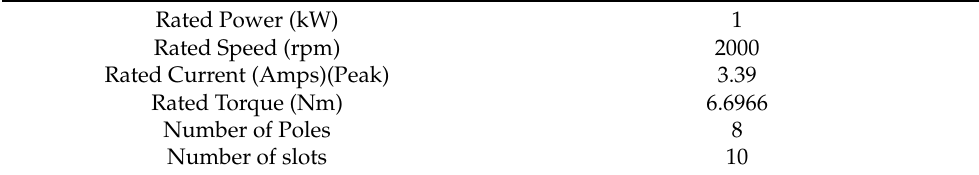
Table 1. Parameters of The Five-Phase PM Machine “Reprinted from Publisher, 2021 [44]”.